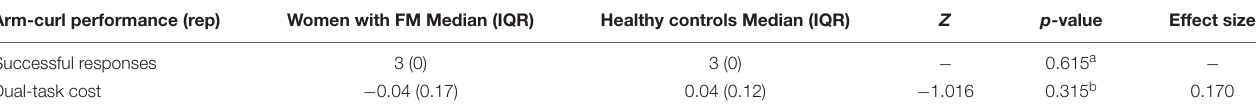
TABLE 3 | Between-group comparisons in the dual-task cost and cognitive performance in the arm-curl test in women with FM and healthy controls. Arm-curl performance (rep) Women with FM Median (IQR)